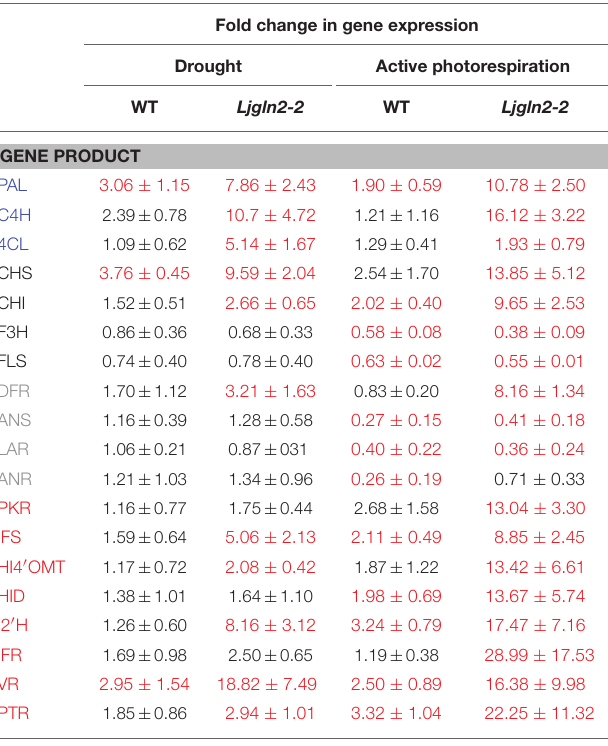
TABLE 3 | Changes in the relative expression levels of selected genes for the biosynthesis of phenolic compounds measured by qRT-PCR. Fold change in gene expression